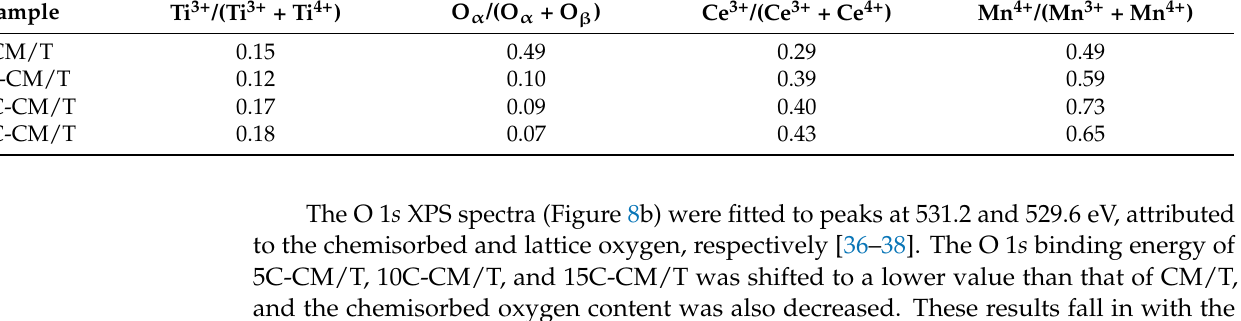
Figure 7. ( a ) H 2 -TPR curves and ( b ) H 2 consumption of CM/T, 5C-CM/T, 10C-CM/T, and 15C-CM/T.